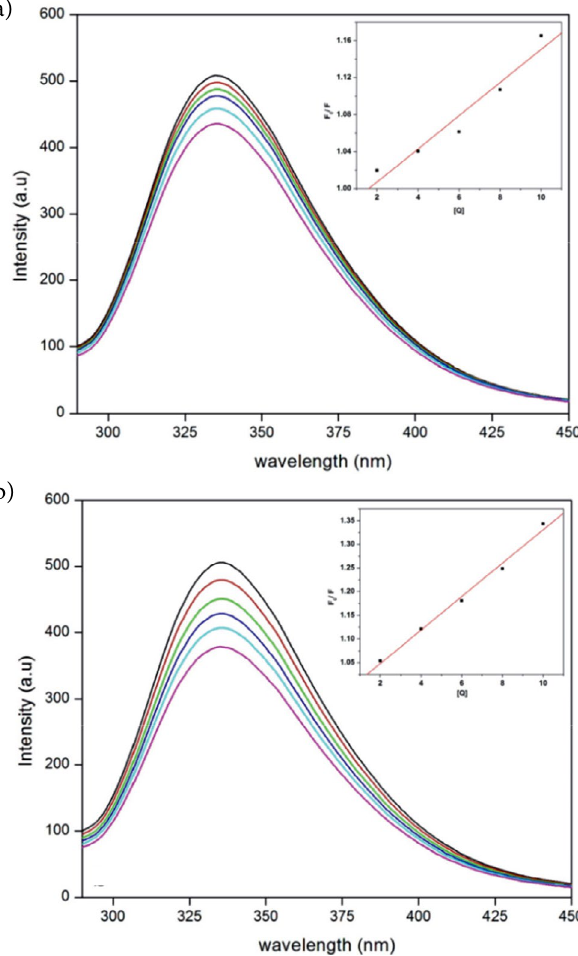
Fig. 5: Emission spectra of BSA in the presence of various concen- trations of metal complexes in DMSO ( T = 298 K), c (BSA)=2.0 × 10 –6 mol L –1 , c (Metal complex) = 2, 4, 6, 8, 10 × 10 –6 mol L –1 . Insert: Stern-Volmer plot for quenching of BSA by metal complexes (a) Emission spectra of BSA with MnL complex (b) Emission spectra of BSA with FeL